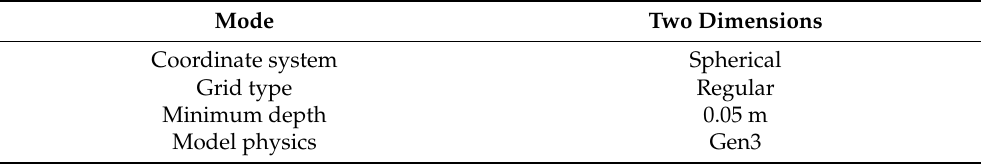
Table 3. Basic set of the SWAN model.